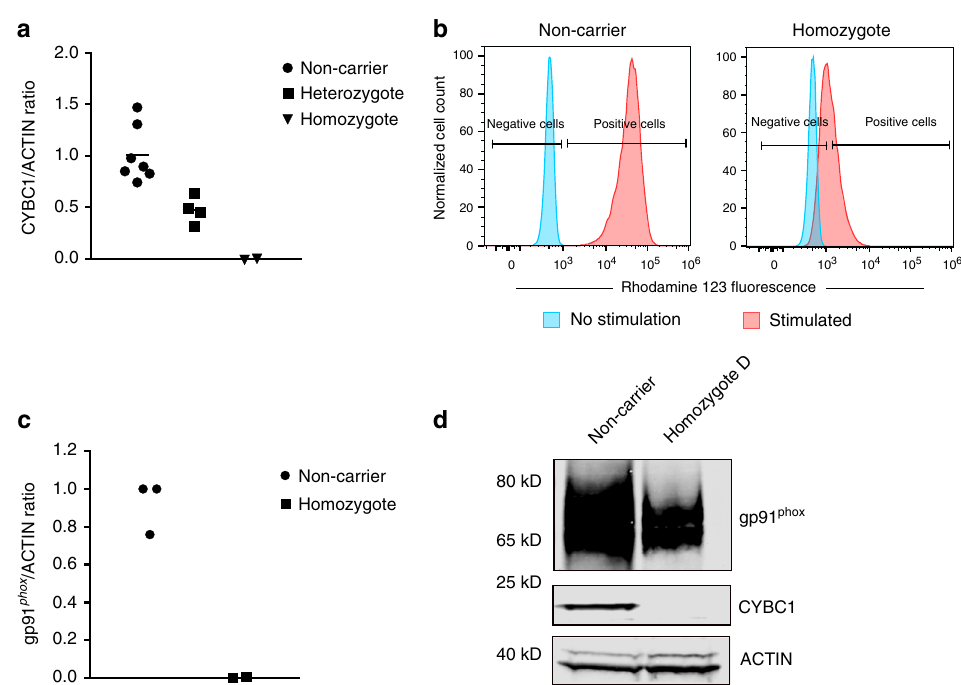
Fig. 2 Effect of p.Tyr2Ter on CYBC1, the neutrophil oxidative burst, and gp91 phox . a CYBC1 protein expression, relative to ACTIN, in lymphocytes from CYBC1 p.Tyr2Ter homozygous individuals D and F (triangles), four heterozygous carriers (squares), and matched (age and sex) non-carriers (circles). CYBC1 expression was not detected in the homozygous individuals in contrast to their matched non-carriers, and was reduced by 53% in the